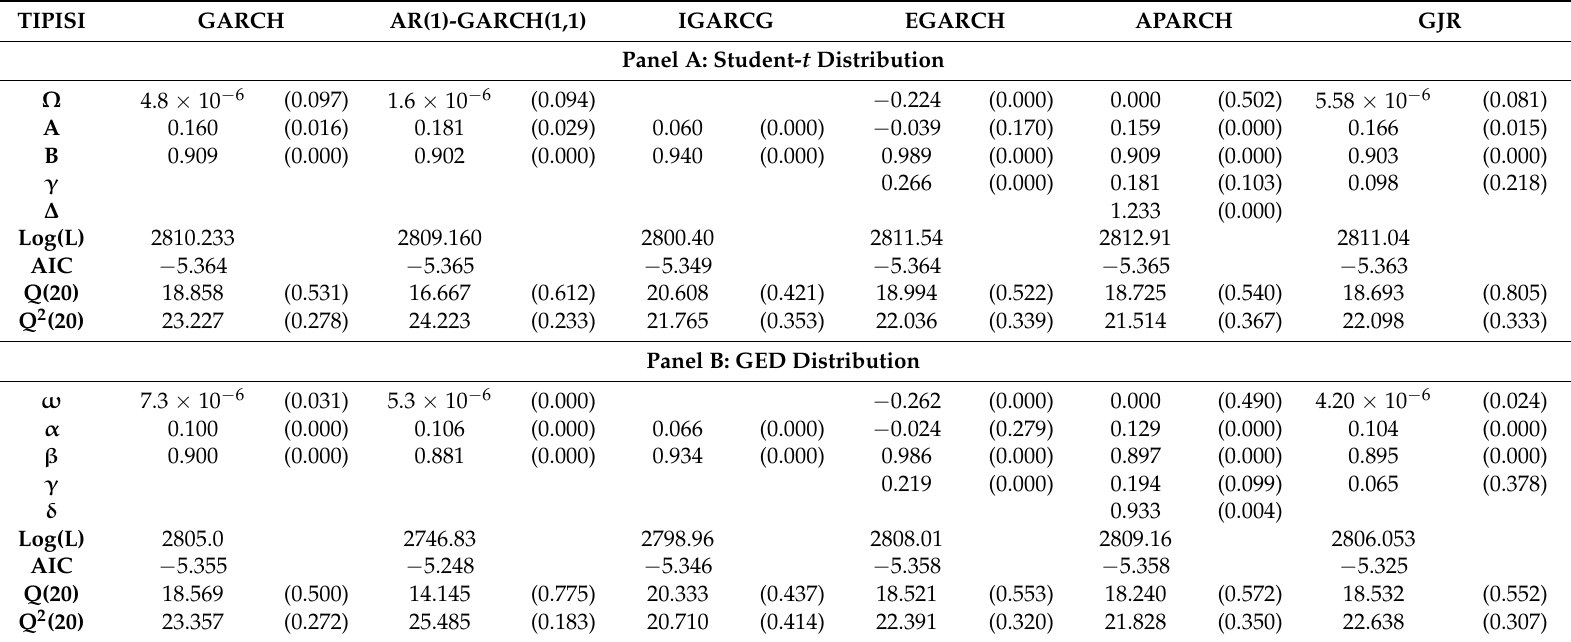
Table 3. Estimation results of different volatility model on the TIPISI. This table presents the in-sample estimation results for the different volatility models during the period of 10 September 2007 to 3 August 2014. Panel A presents the in-sample estimation results using Student- t distribution. Panel B presents the in-sample estimation results using GED distribution. Log(L) is the logarithm maximum likelihood function value. AIC is the average Akaike information criterion. Q(20) is the Ljung-Box Q-statistic of order 20 computed on the standardized residuals. Q 2 (20) is the Ljung-Box Q-statistic of order 20 computed on the squared standardized residuals. Numbers in parentheses are the p